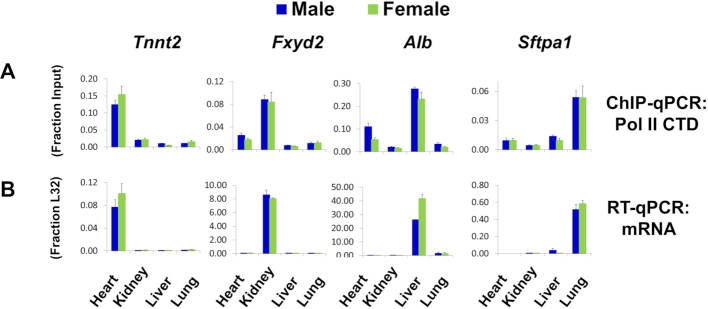
PIXUL-ChIP analysis of Pol II occupancy in mouse heart, kidney, liver, and lung. Flash frozen heart, kidney, liver and lung samples from male and female mice were cross-linked and then sonicated in microplates using PIXUL. (A) PIXUL-sheared chromatin samples were simultaneously analyzed for Pol II levels at indicated organ-specific genes using Matrix ChIP. ChIP DNA was analyzed by qPCR expressed as fraction of input. Data represent mean ± SEM (n = 3 mice) expressed as a fraction of input. (B) RNA isolated from the same frozen organs as in A was used in RT-qPCR with primers to indicated genes. Data represent mean ± SEM (n = 3 mice) expressed as a ratio to the transcript levels of housekeeping ribosomal protein gene, L32. These results demonstrate that PIXUL-ChIP can be used to analyze multiple samples from several organs on the same plate.